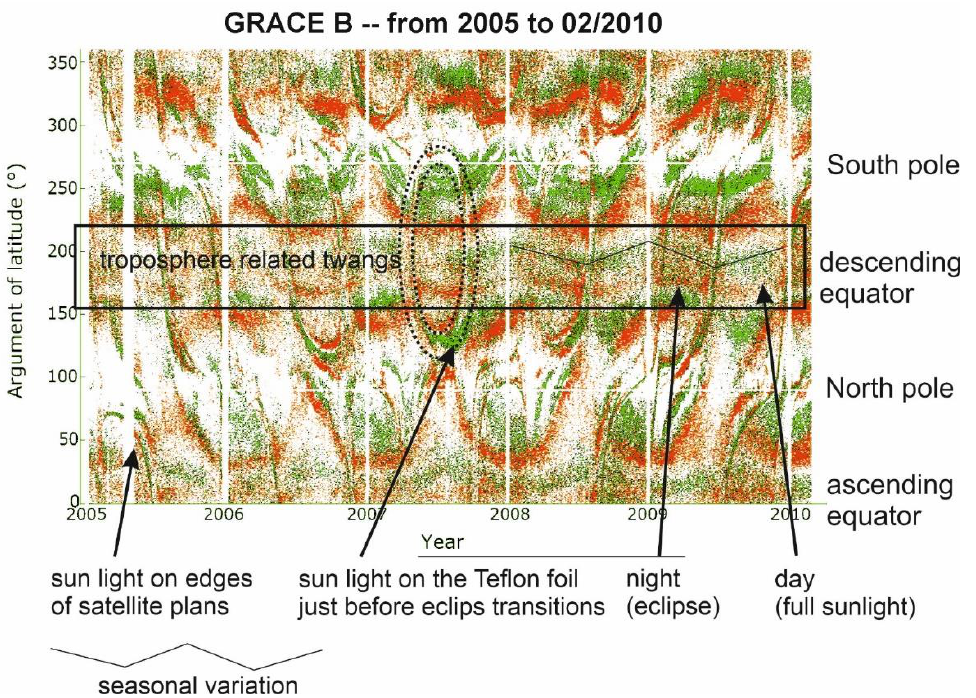
Figure 6. Detected twangs on the accelerometer in radial direction of GRACE B with argument of latitude. Positive twangs are marked in green, while negative twangs are marked in red. Positive spikes go up then down, while negative spikes go down then up. We can relate sharp structures to sun illumination of individual surfaces of the satellite. We mark the eclipse phase by an oval when sun hits the nadir foil. The number of twangs varies between daytime and nighttime. A seasonal variation in latitude of cloud-related twangs is marked by the zig-zag structure.